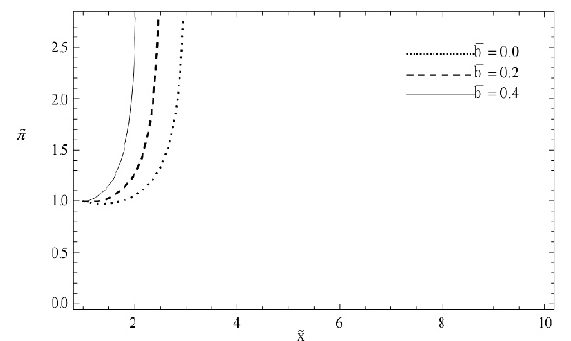
Figure 8. The growth of shock strength ( and γ = 5/3.